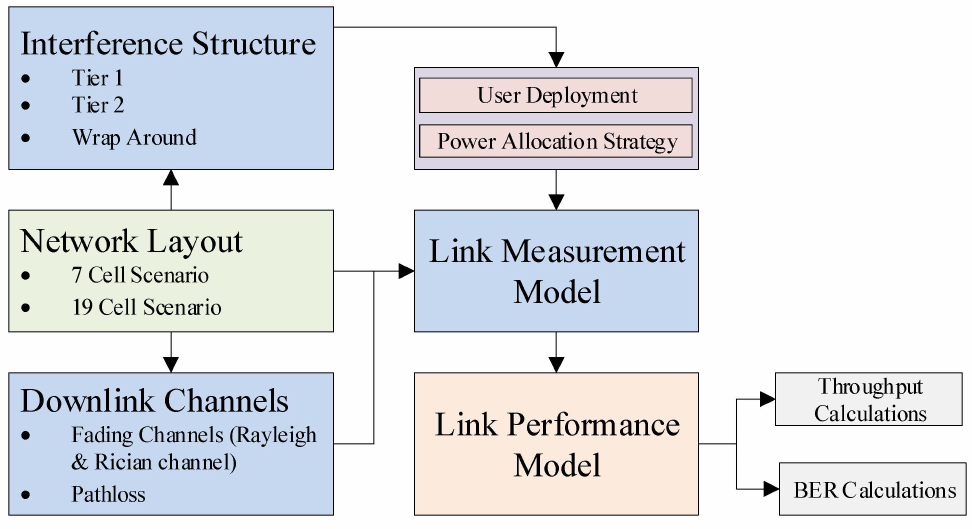
Figure 3. Block diagram of NOMA system-level